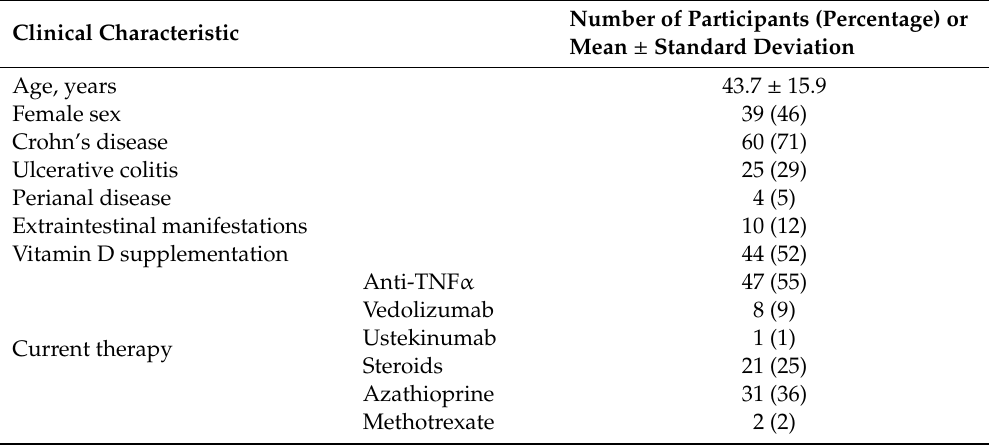
Table 3. Baseline clinical characteristics of patients meeting inclusion